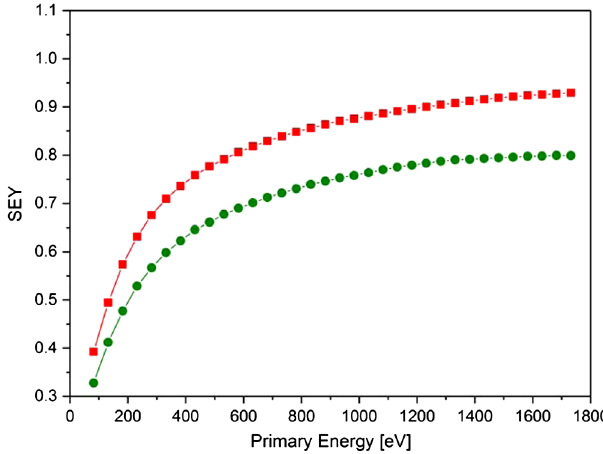
FIG. 7. SEY comparison of CH (green circles) vs LH (red squares) patterns for samples from the University of